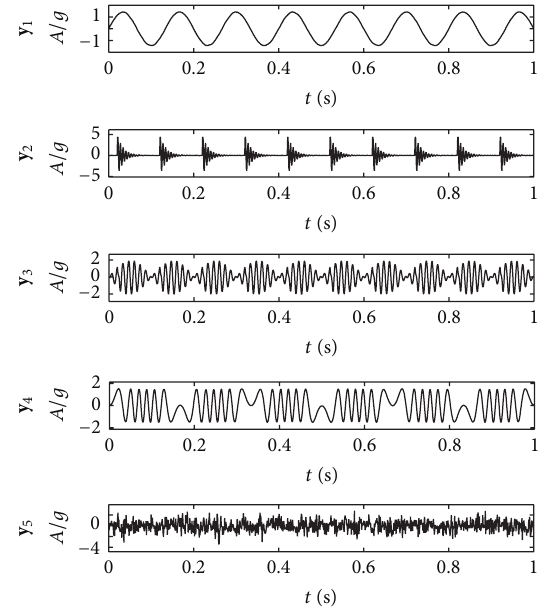
Figure 3: Separated components by DSS.